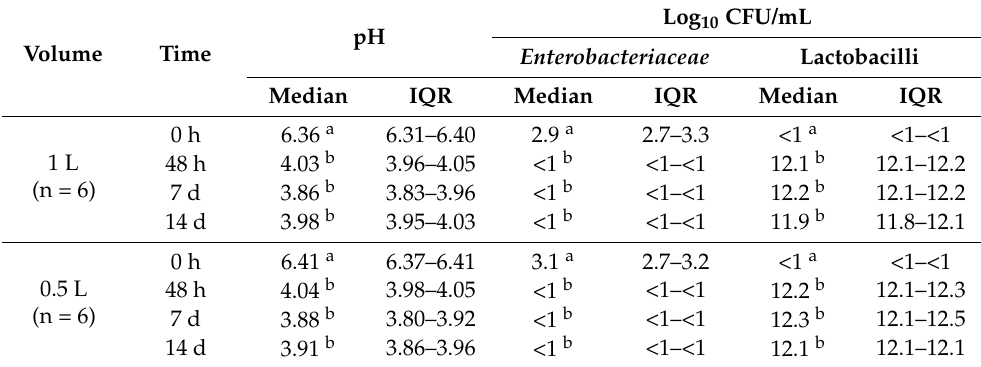
Table 2. pH, Enterobacteriaceae and lactobacilli count in the fermented quinoa-based beverage.